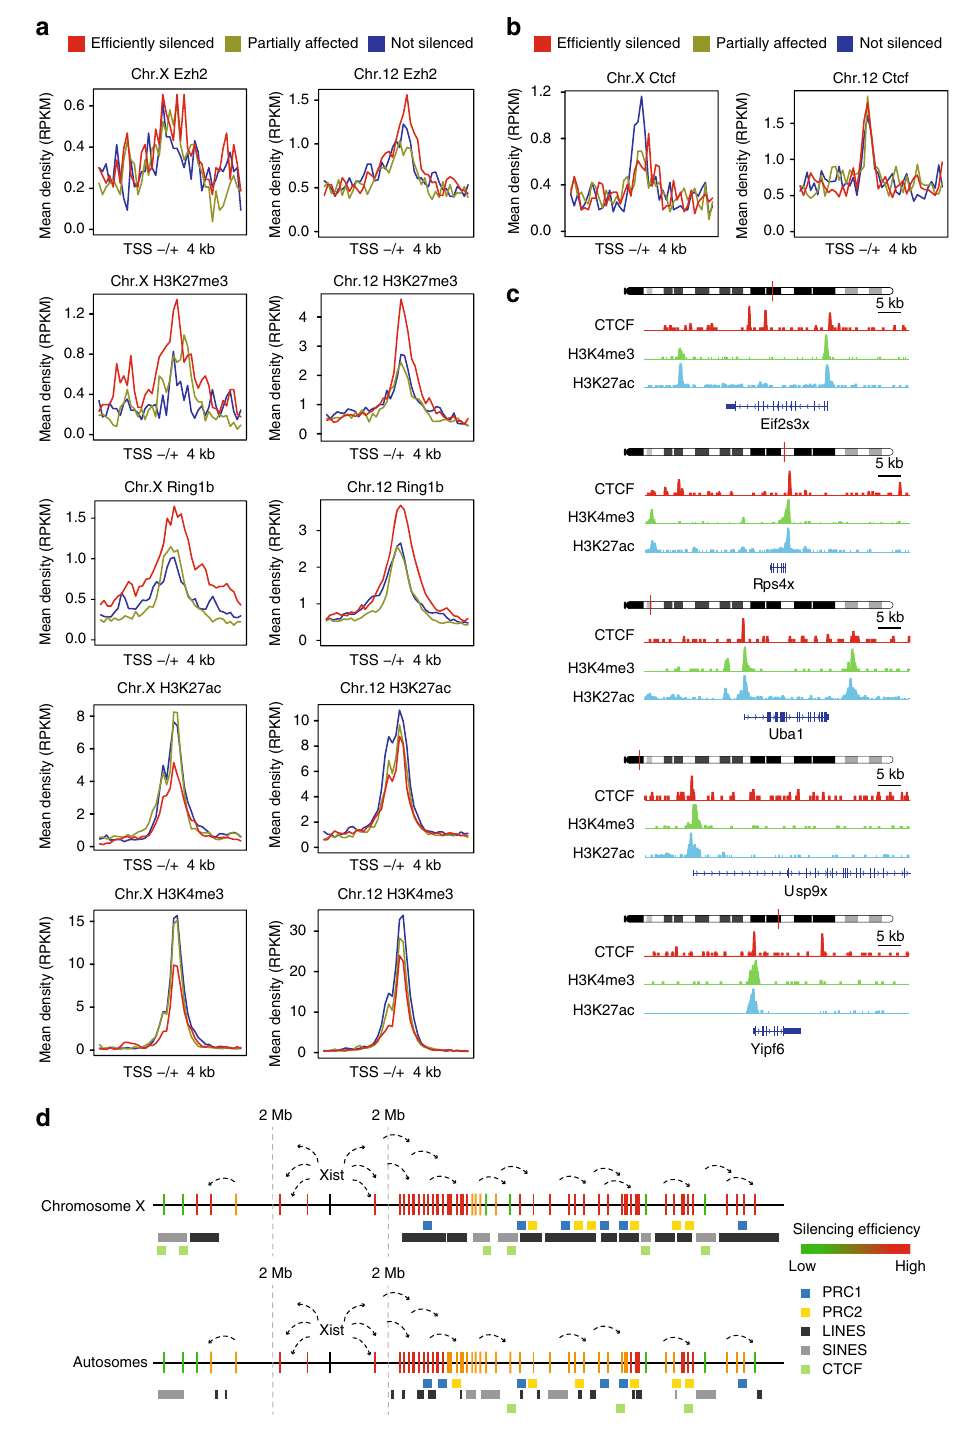
Fig. 7 Chromatin environment and CTCF enrichment predispose gene silencing and escape. Average density plots for Ezh2, H3K27me3, Ring1b, H3K27ac, H3K4me3 a , and CTCF b in 8 kb bins around the TSS of X-linked and autosomal genes. c ChIP-seq analysis showing CTCF, H3K4me3, and H3K27ac enrichment at the TSS of fi ve not silenced genes. d Model for Xist-mediated silencing. Both X-linked and autosomal genes are ef fi ciently silenced in linear proximity of the Xist transcription site, regardless the genomic environment. Long-range gene silencing is more ef fi cient for X-linked genes and relies on LINE elements and PRC1/2 complexes. CTCF sites overlap with SINE elements and CTCF binding mediates X chromosome-speci fi c escape from